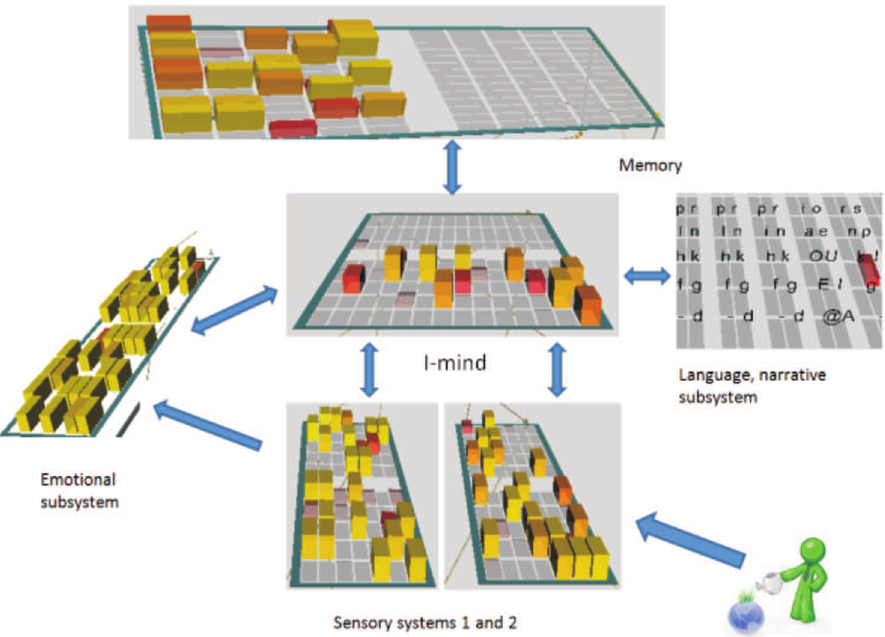
Figure 1. Neural layers representing two sensory inputs, emotional and language subsystems and memory, with I-mind layer that represents and binds percepts. Each box represents neural cell assembly, activity is represented by the hights of the box. Strength of connections between these assemblies is learned during network